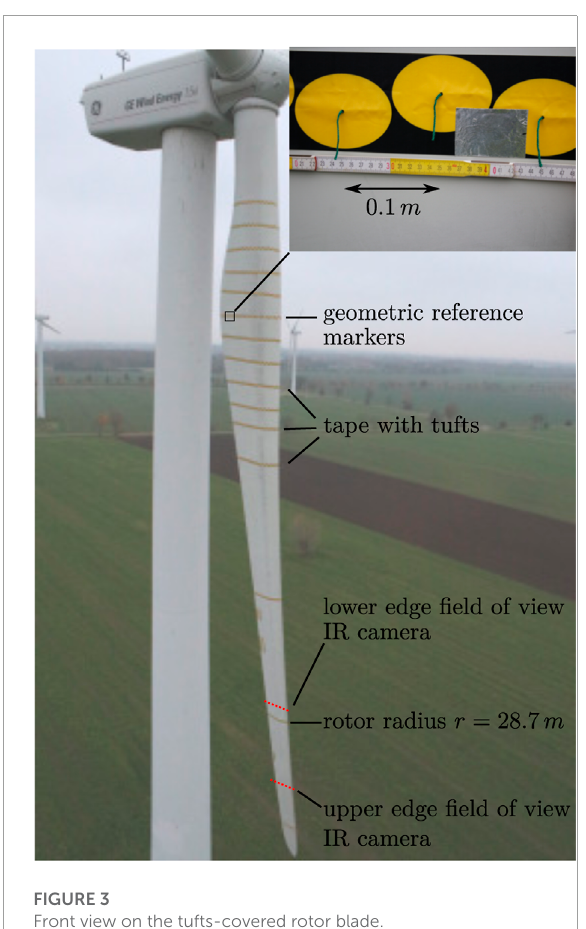
FIGURE 3 Front view on the tufts-covered rotor blade.